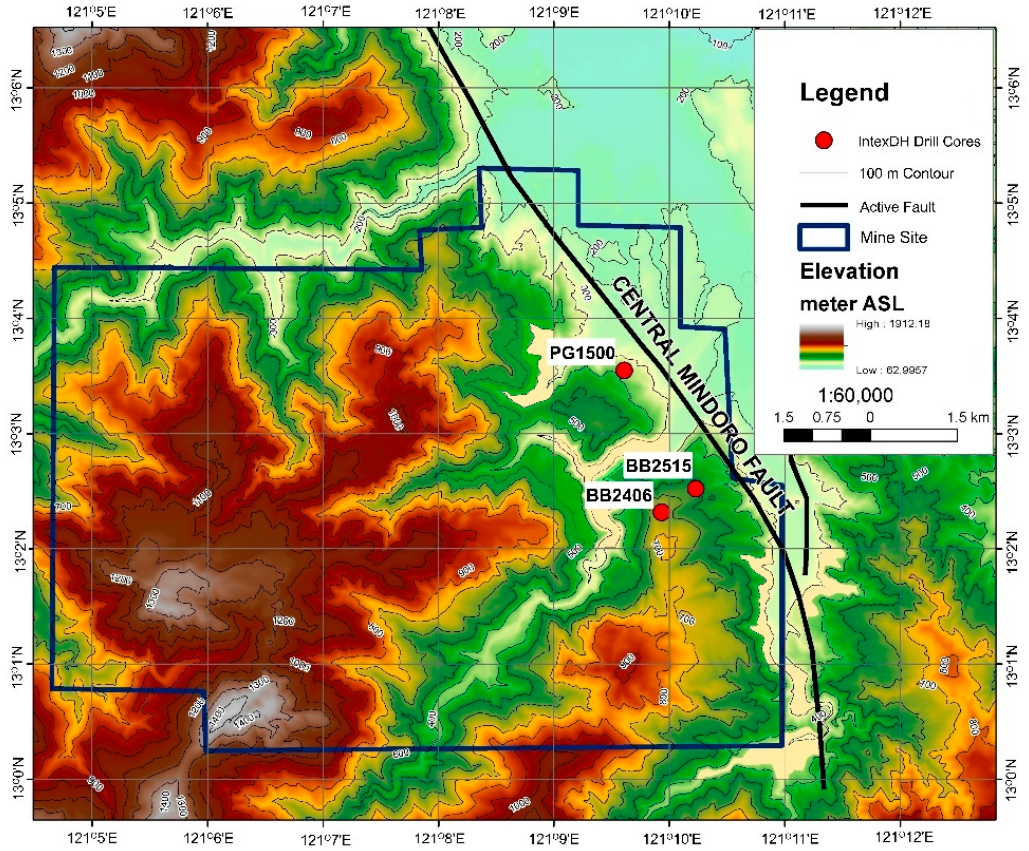
Figure 2. Relief map showing the studied drill cores within the Intex’s exploration project area.